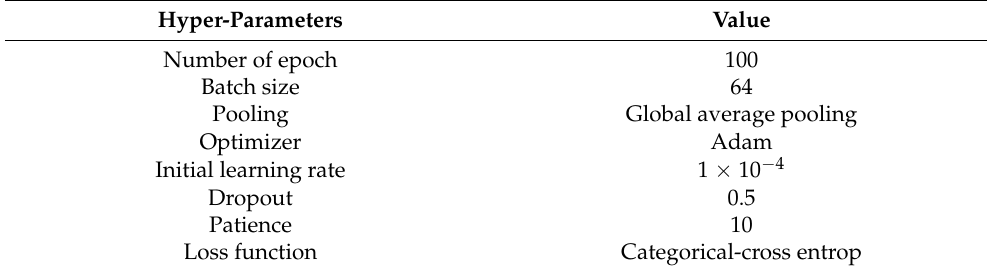
Table 3. Values of the hyperparameters used in the CNN model